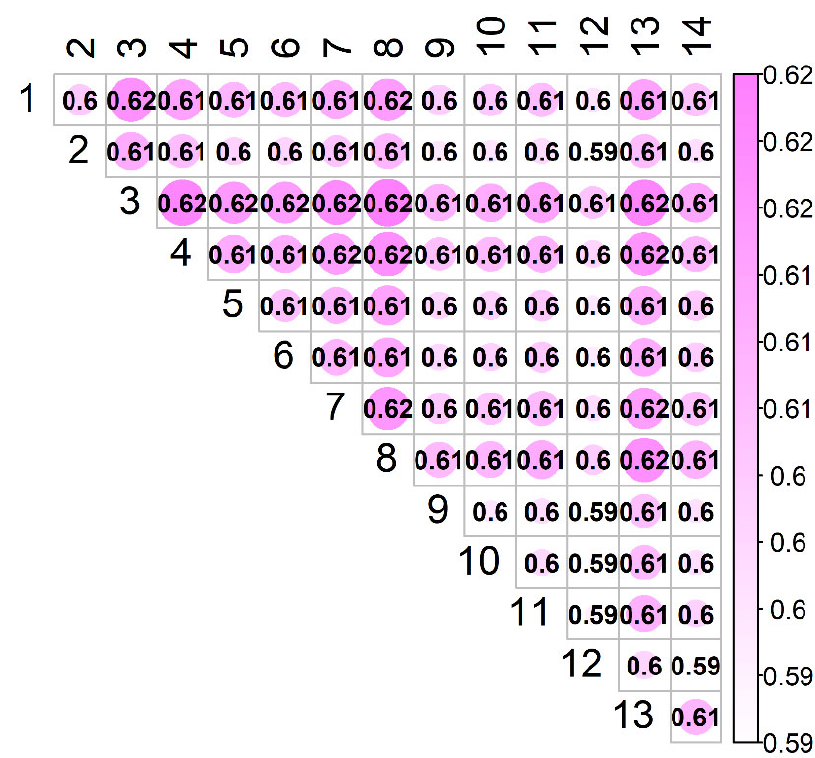
Figure 7. Estimates of connectedness between 14 flocks of Istrian sheep based on CD ind ( i , j ) .